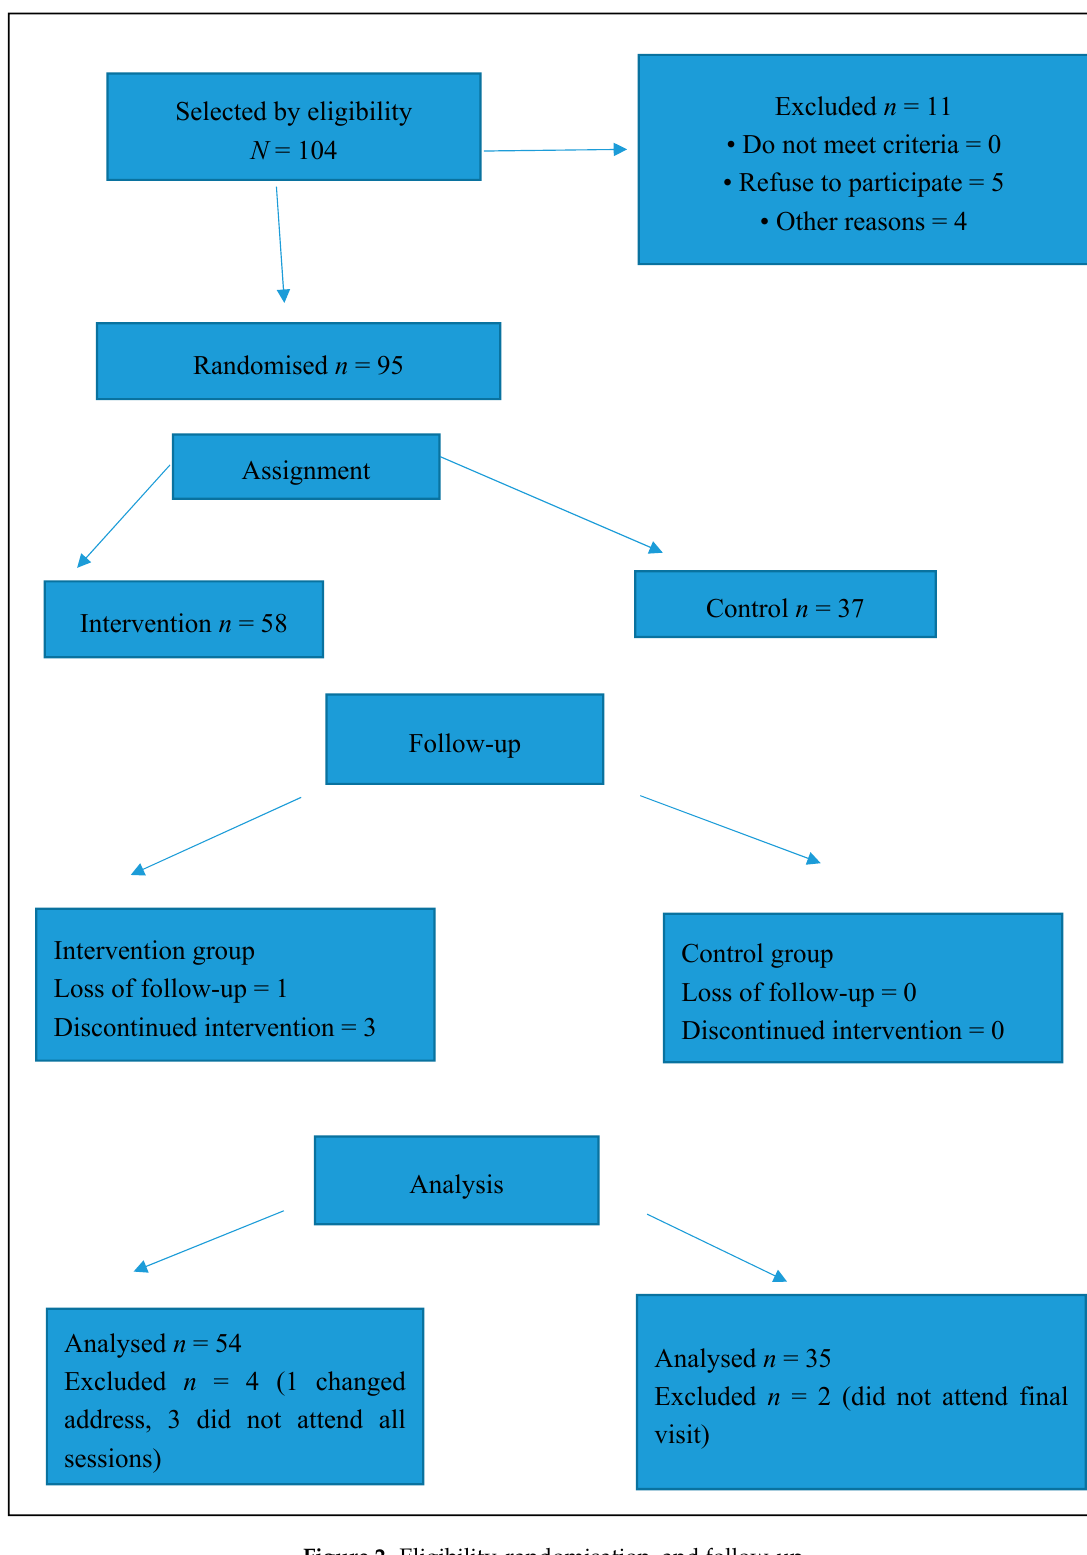
Figure 2. Eligibility, randomisation, and follow-up.